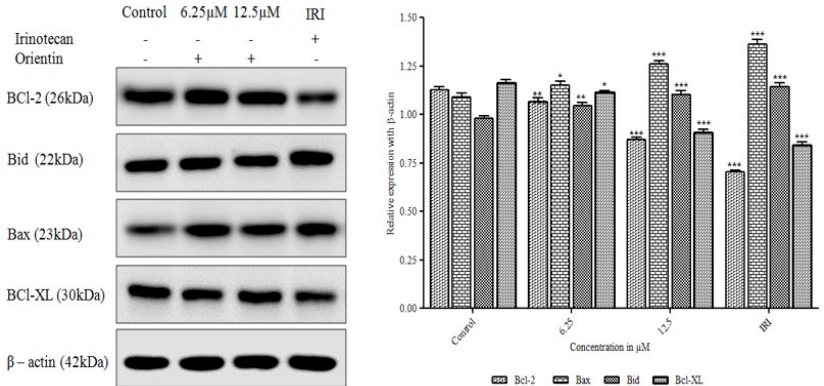
Figure 8. Effect of orientin on expression of Bcl-2 family proteins. HT-29 cells were treated with orientin (6.25 and 12.5 µM) and irinotecan for 24 h, respectively. Orientin increases proapoptotic Bax and Bid proteins and decreases the expression of anti-apoptotic Bcl-2 and Bcl-XL proteins. β -actin was used as an internal control. Quantitative expression of proteins shown after normalization to β -actin. Data are represented as the mean ± SD of three independent experiments (* p < 0.05, ** p < 0.01 and *** p < 0.001 vs.